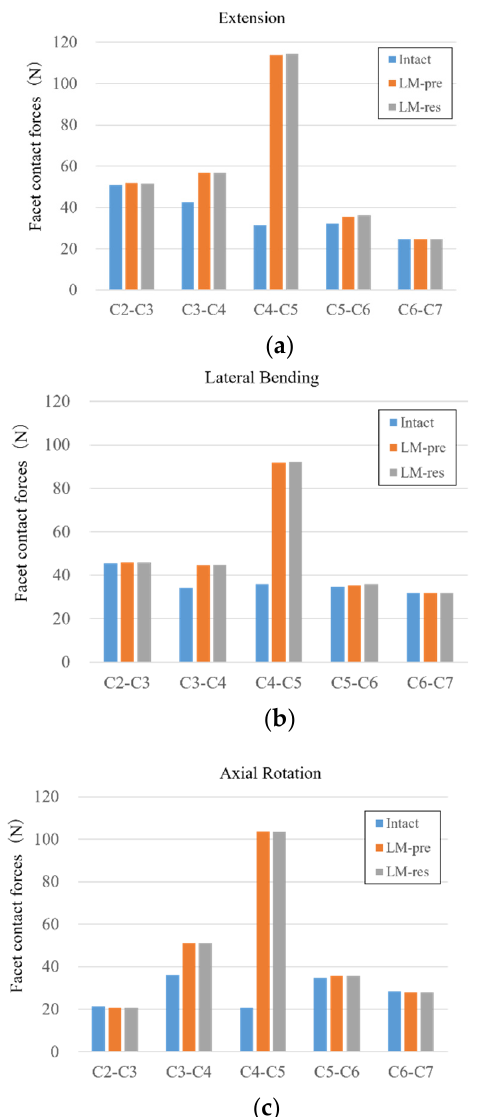
Figure 8. Facet contact forces. ( a ) Extension, ( b ) lateral bending, ( c ) axial rotation. Vertical axis is force (N), horizontal axis is each intervertebral level.